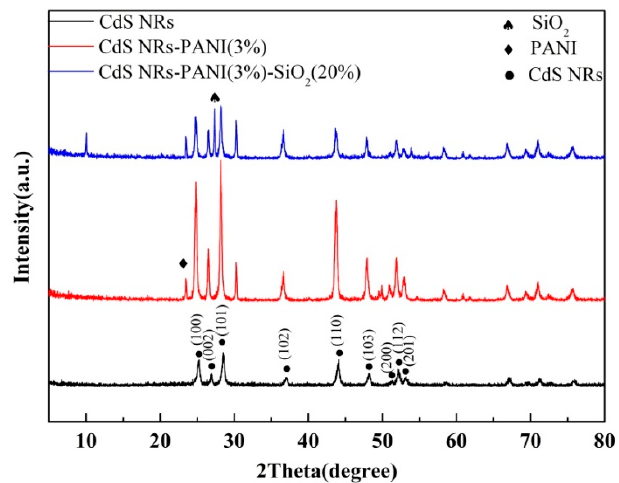
Figure 2. X-ray diffraction (XRD) spectra of CdS NRs, CdS NRs-PANI (3%), and CdS NRs-PANI (3%)-SiO 2 (20%).